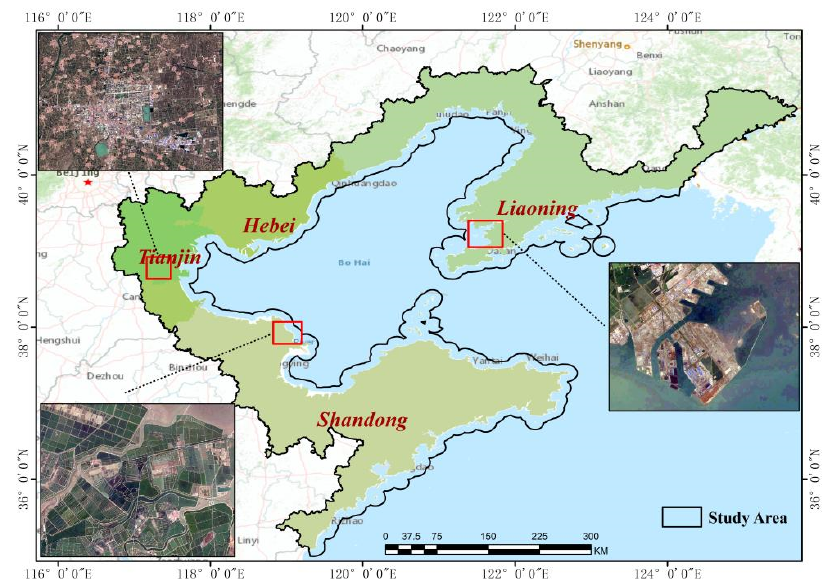
Figure 1. Location of the study area. Table 1. Coastal zone landscape function classification